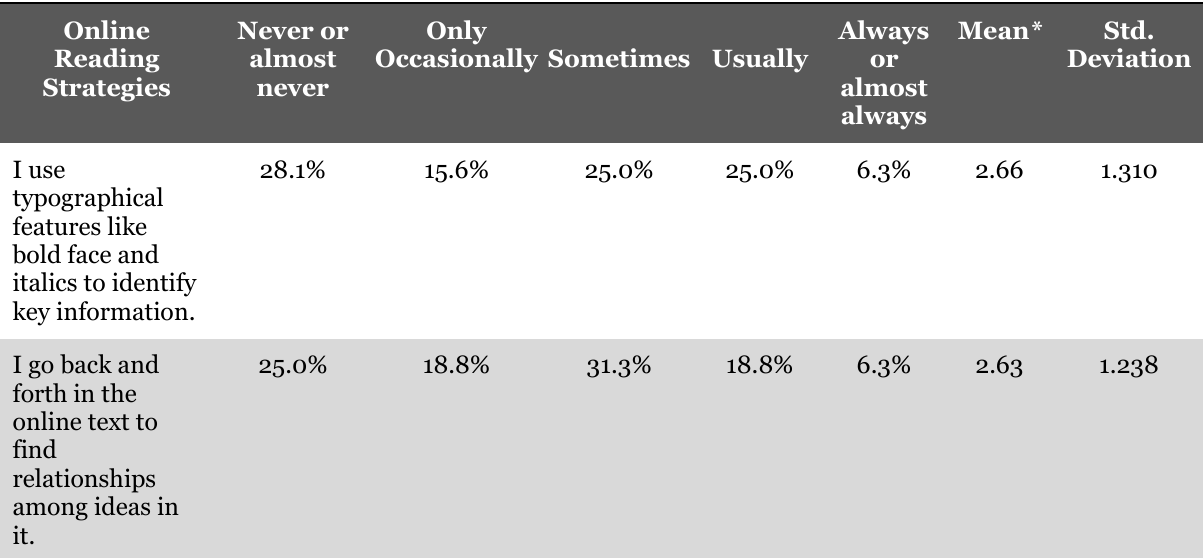
Least Frequently Used Strategies by Language Learners for Online Reading in Foreign